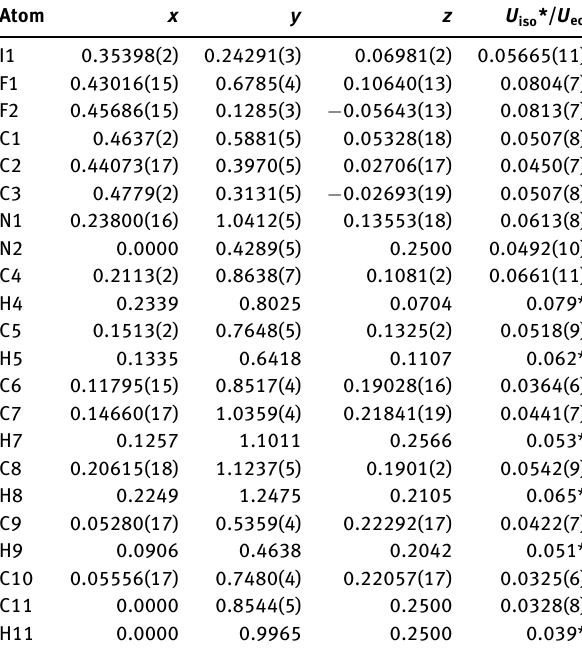
Figure 1: Molecular structure of the title complex with dispalcement ellipsoids draw at the 50% proability level.